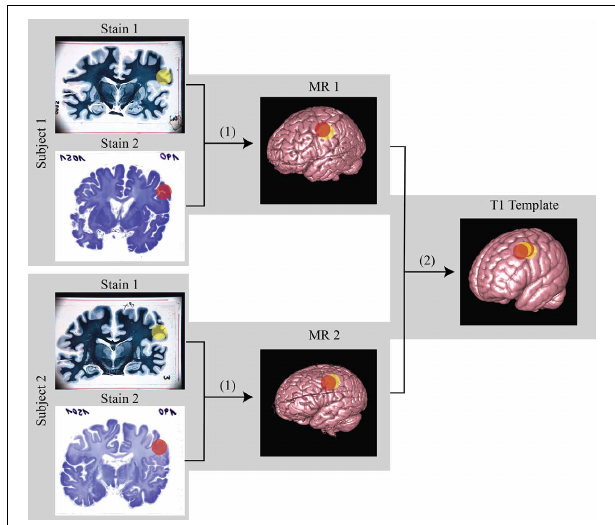
FIGURE 10 | Schematic diagram of the registration from histology to MR and then to standard template. (1) linear/non-linear registration from histology space to MR space; (2) non-linear registration from MR space to standard template space. Using this transformation matrix, histology can be transformed to template space as well. The color sphere labels mark the region of interest